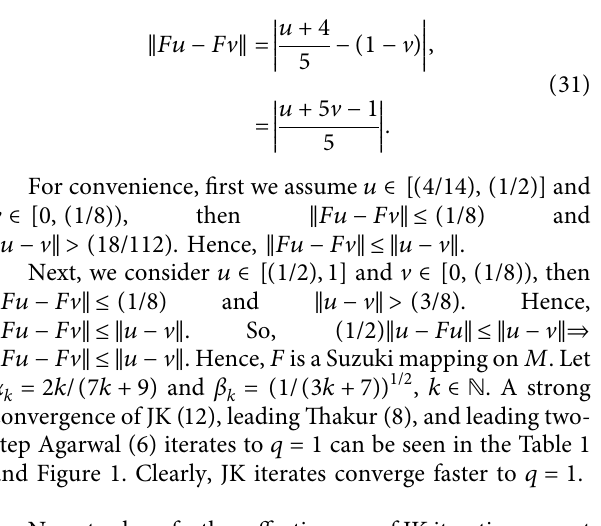
Table 4: α Iteratesnumber toconverge aniterationto